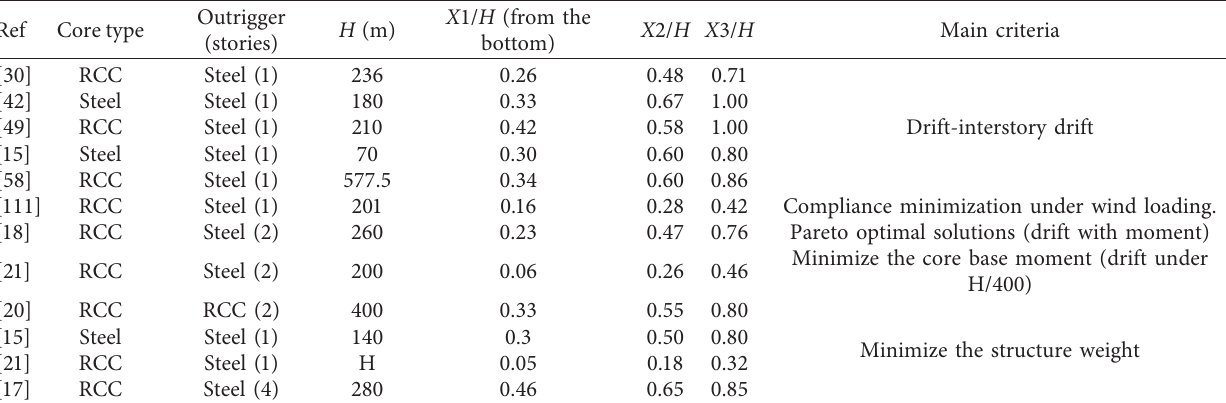
Table 7: Three outrigger